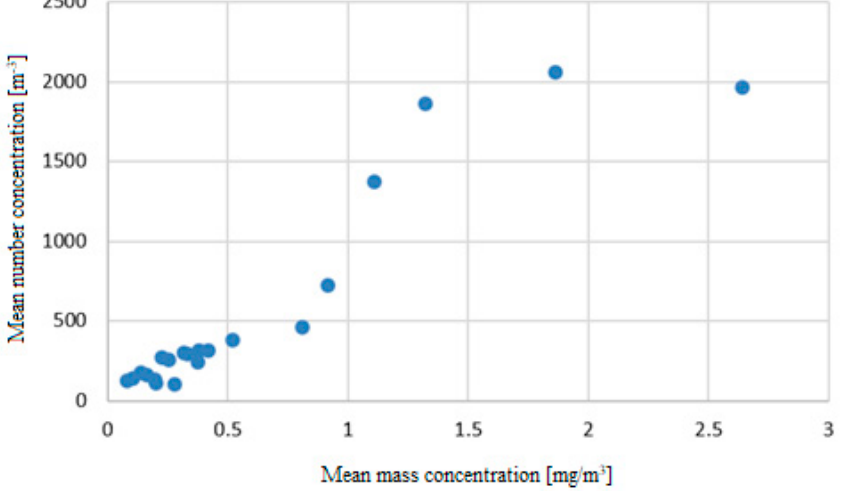
Figure 9. Relationships between mean values of number and mass concentration of asbestos dust.